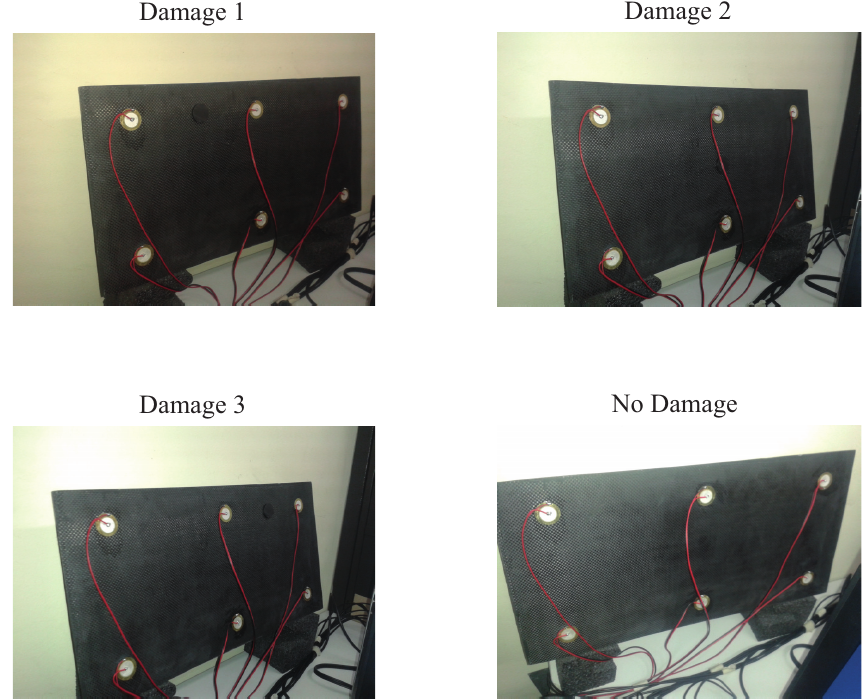
Figure 30. Experimental setup for the composite plate instrumented with six piezoelectric sensors.